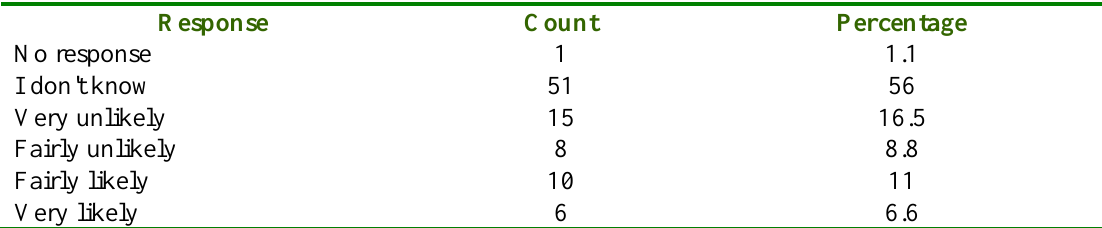
Table 3. Blackboard’s Ability to Assist CQU to Become a Flexible Learning